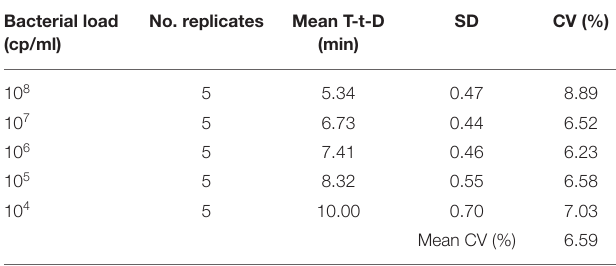
TABLE 3 | Results of precision (inter-assay variability) for the LAMP assay.